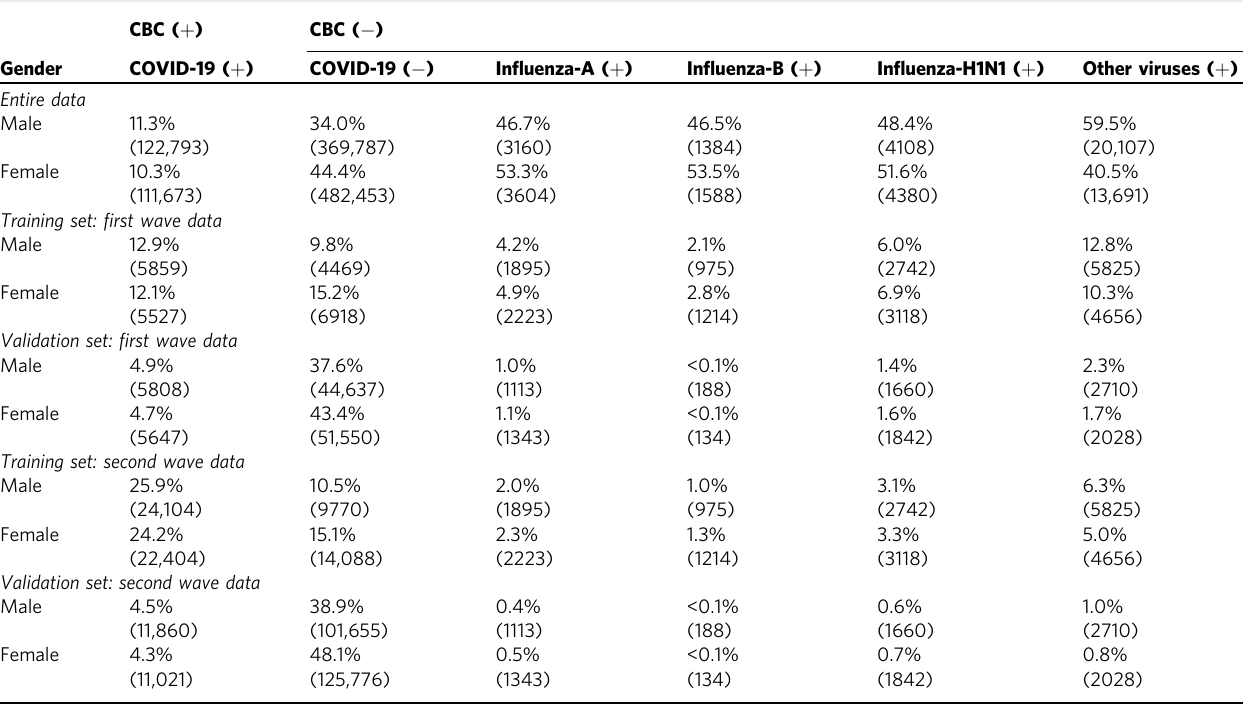
Table 2 Entire dataset, training sets, and validation sets for the two waves that occurred during the Brazilian COVID-19 outbreak.